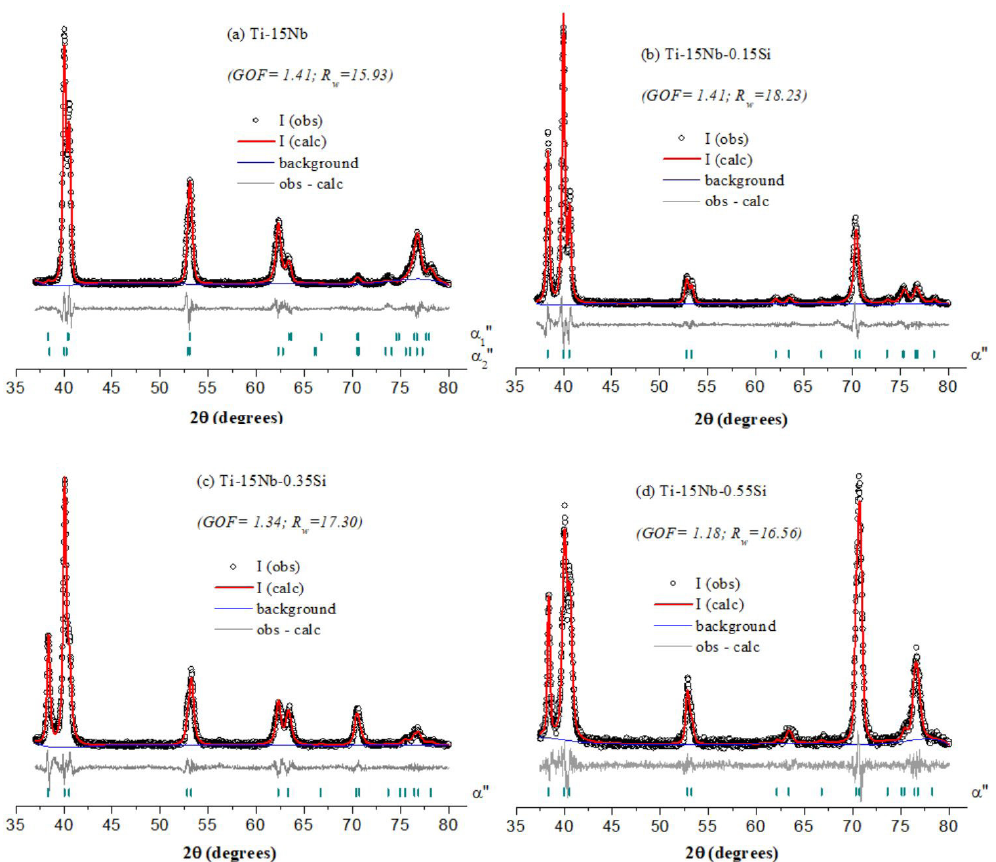
Figure 6. Observed (○) and calculated (solid red line) XRD patterns recorded for WQ Ti-15Nb-xSi samples. The difference (solid grey line) is shown at the bottom of the image and Bragg reflections are indicated by vertical Table 3. Values of lattice parameters and volume fractions of the α” phase recorded for all observable reflections of water-quenched Ti-15Nb-xSi samples. Nominal content (wt.%)